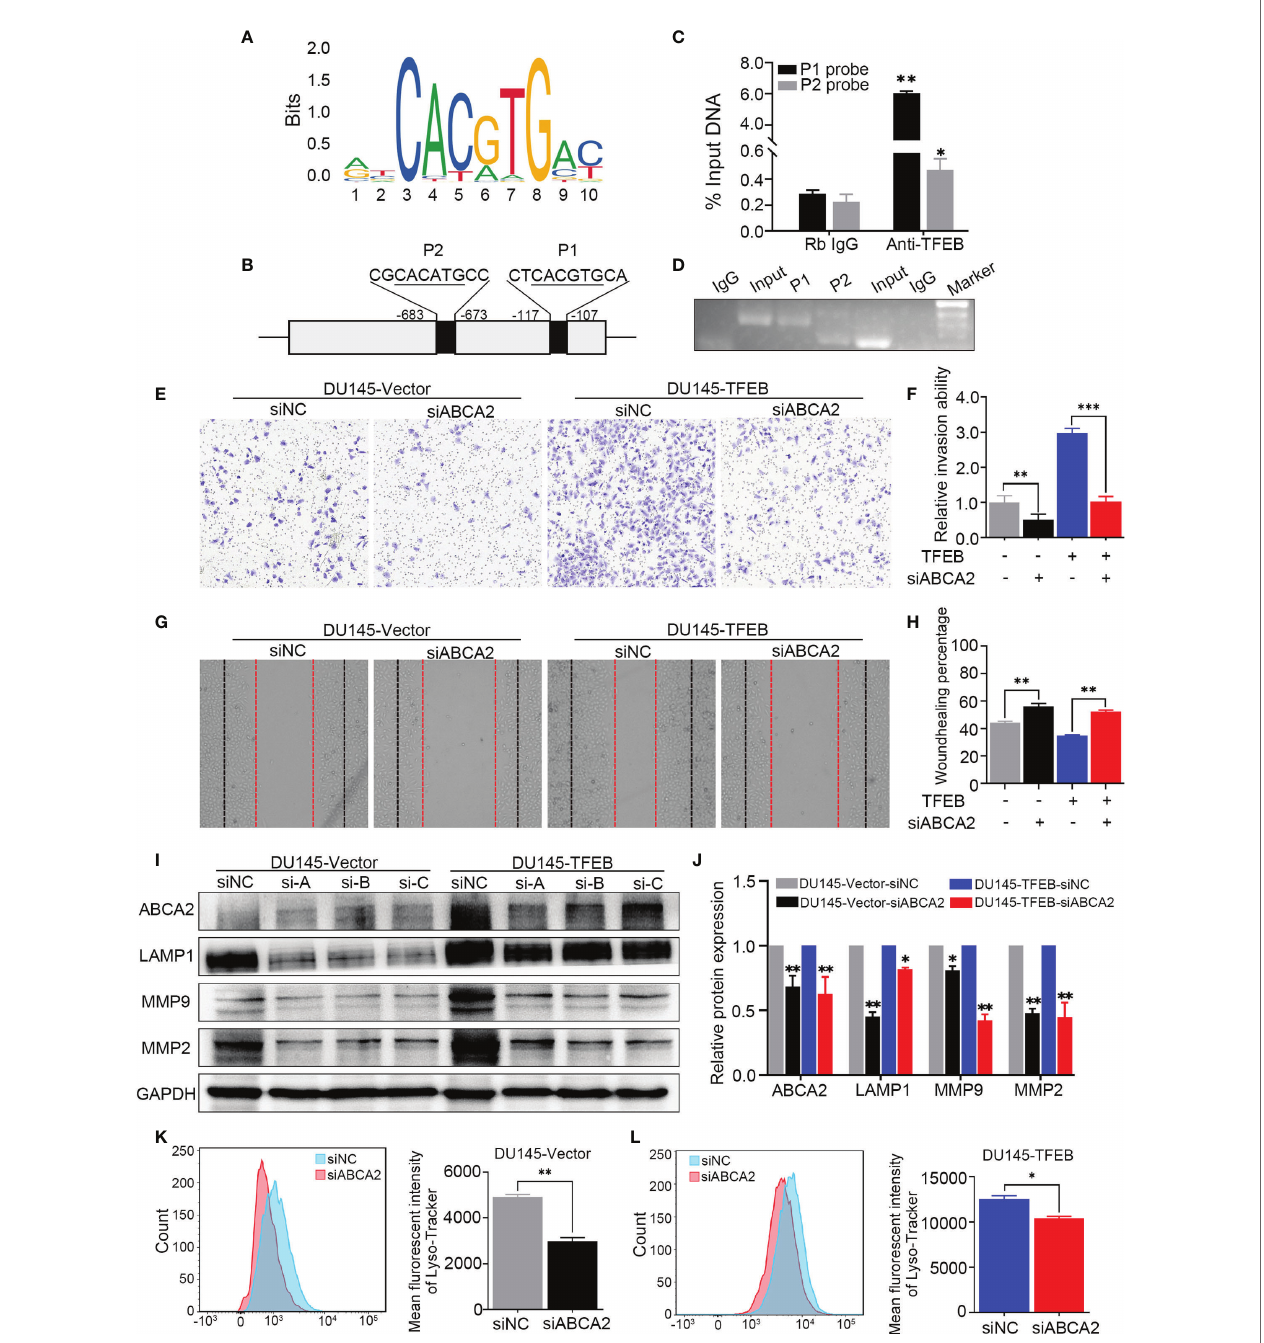
FIGURE 6 | TFEB binding ABCA2 promoter to regulate its expression to involve PCa cell invasion and migration. (A) The binding motif of TFEB were provide from website. (B) The potential binding site of ABCA2 promoter. Mismatch rate is less than 1%. (C) Validation of the DNA fragment pulled down with TFEB chip-level antibody by qRT-PCR. DNA fragment were obtained from CUT&RUN assay and puri fi ed by DNA extraction kit. Rb IgG as a negative control. Anti-TFEB as an experimental group. (D) The DNA fragment product from qRT-PCR was validated by nucleic acid electrophoresis. The length of input, P1 and P2 mainly between 60 to 120 bp. (E, F) Transwell assay showed silenced ABCA2 expression inhibited PCa cell invasion. Cancer cells were stained after 24h. (G, H) Woundhealing assay showed silenced ABCA2 expression inhibited PCa cell migration after 48h culture. (I, J) Validation of ABCA2 LAMP1, MMP9, and MMP2 protein expression by western-blot after ABCA2 gene silenced. Quantitative analysis of the western-blot from (I) . (K, L) DU145-vector and DU145-TFEB cell line were silenced ABCA2 for 72h and then treated with LysoTracker Red DND-99 (50 nM) for 45 min. Note: Statistical analysis was from three independent experiments and is presented as mean ± SD. * p < 0.05, ** p < 0.01, *** p < 0.001 compared with control